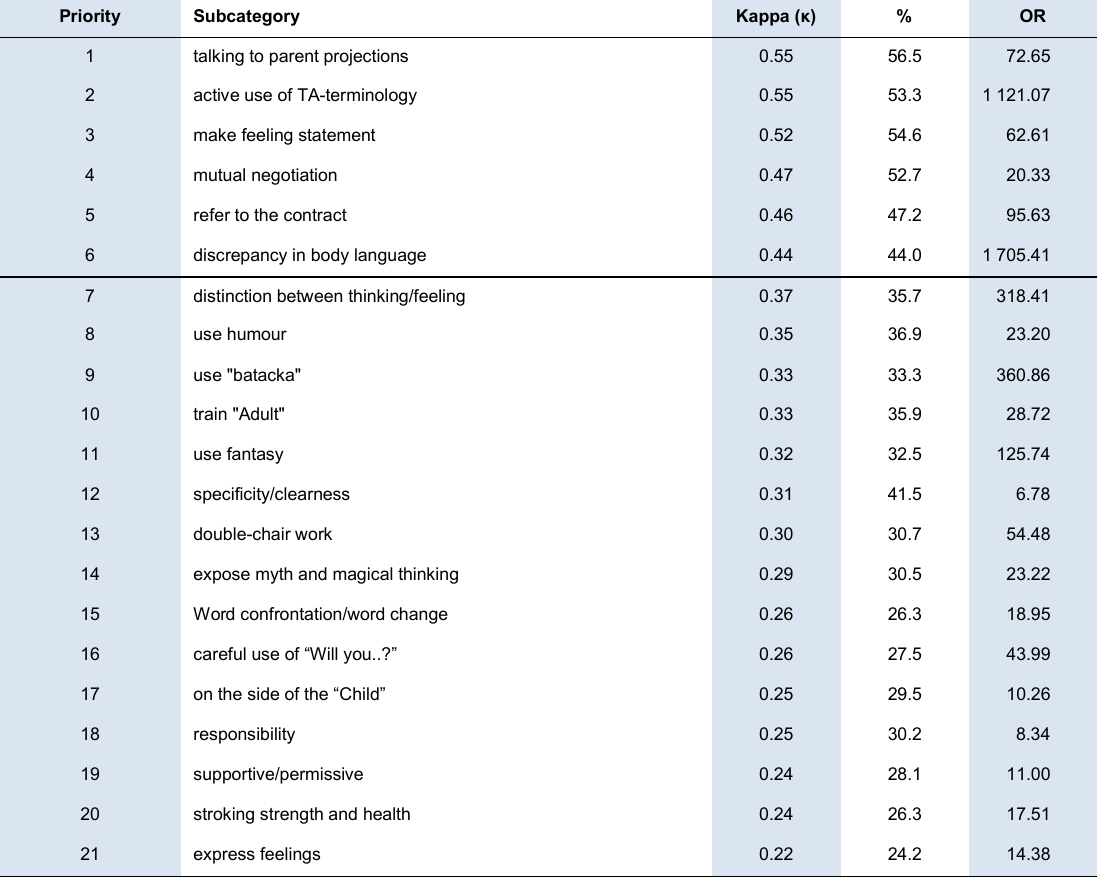
Table 10: Ranking of 21 subcategories’ agreement according to the values of kappa (κ), OR, and percentage agreement